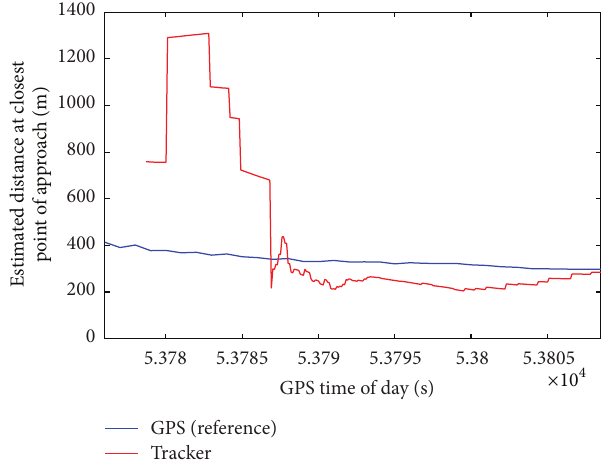
Figure 16: Distance at closest point of approach as measured in flight by GPS (reference) and as estimated by the multisensor tracking algorithm in HWIL tests, as a function of GPS time in the considered